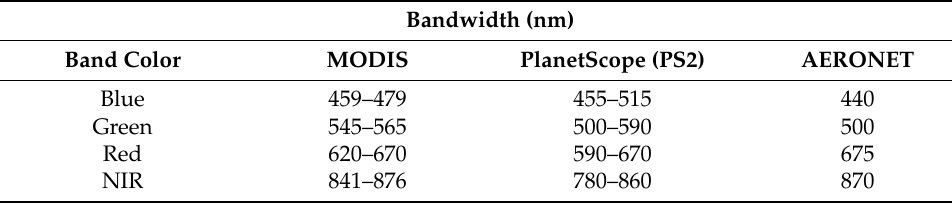
Table 4. Bandwidths of the MODIS, PlanetScope and AERONET bands used for